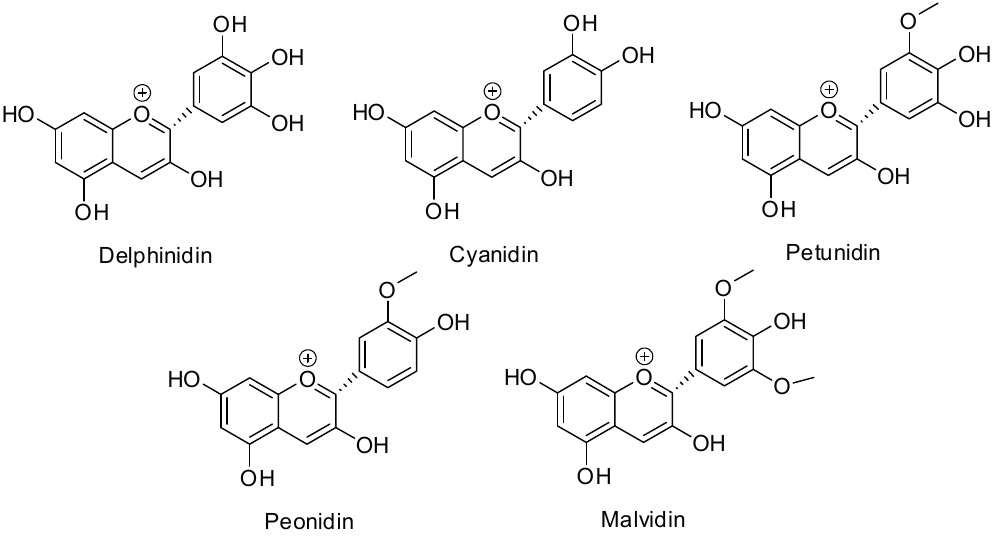
Figure 1. Chemical structures of